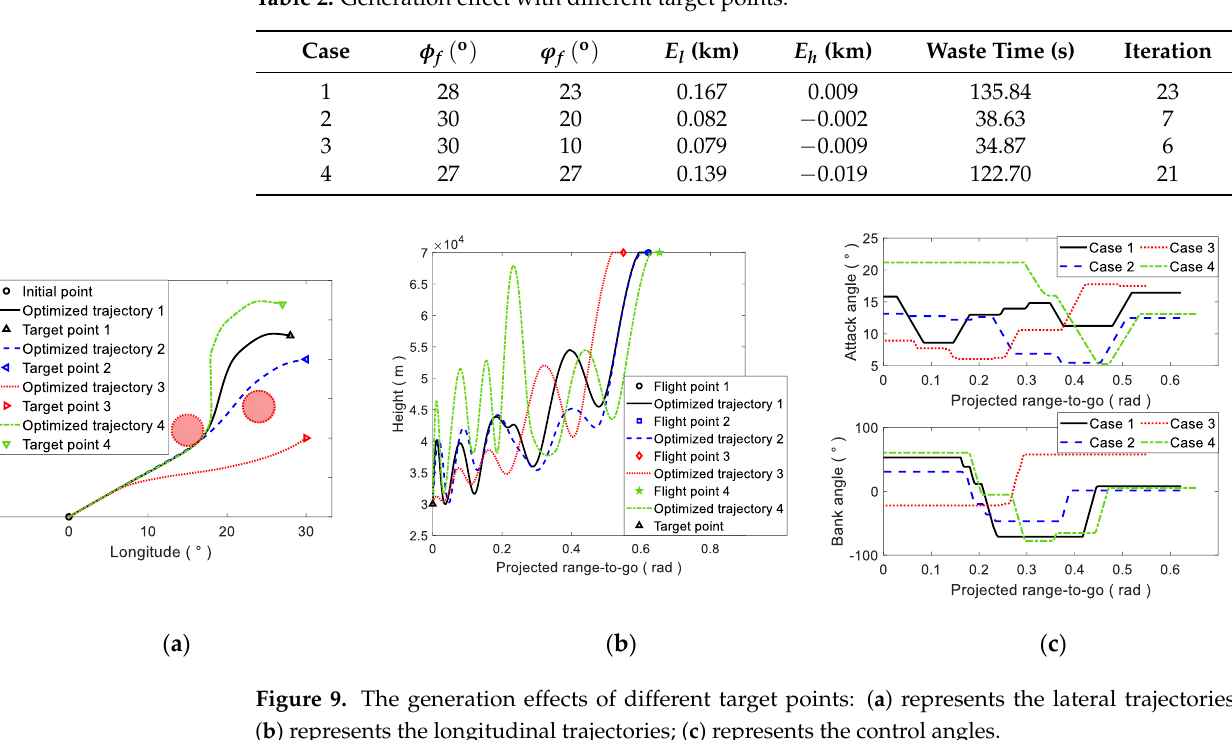
Table 2. Generation effect with different target points.